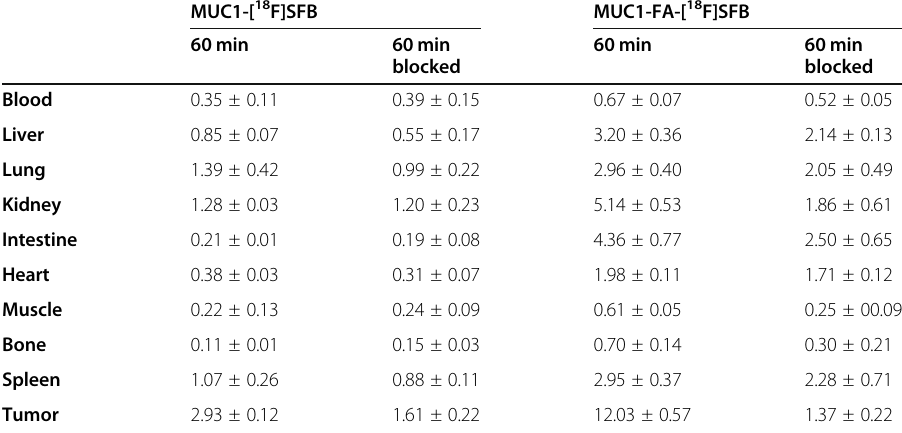
Table 2 Biodistribution of the MUC1-[ 18 F] SFB and MUC1-FA-[ 18 F] SFB hybrid peptide conjugates in tumor-bearing SCID